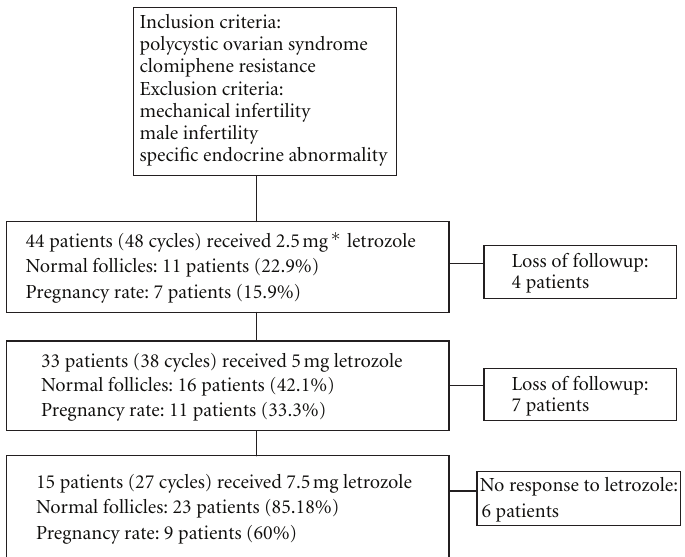
Figure 1: Flow chart of patient’s treatment. ∗ mg